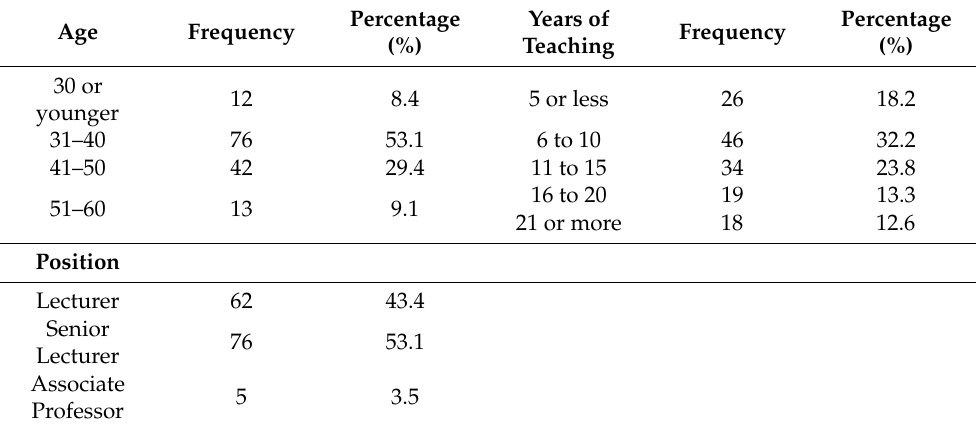
Table 1. Respondent Demographics (n = 143).